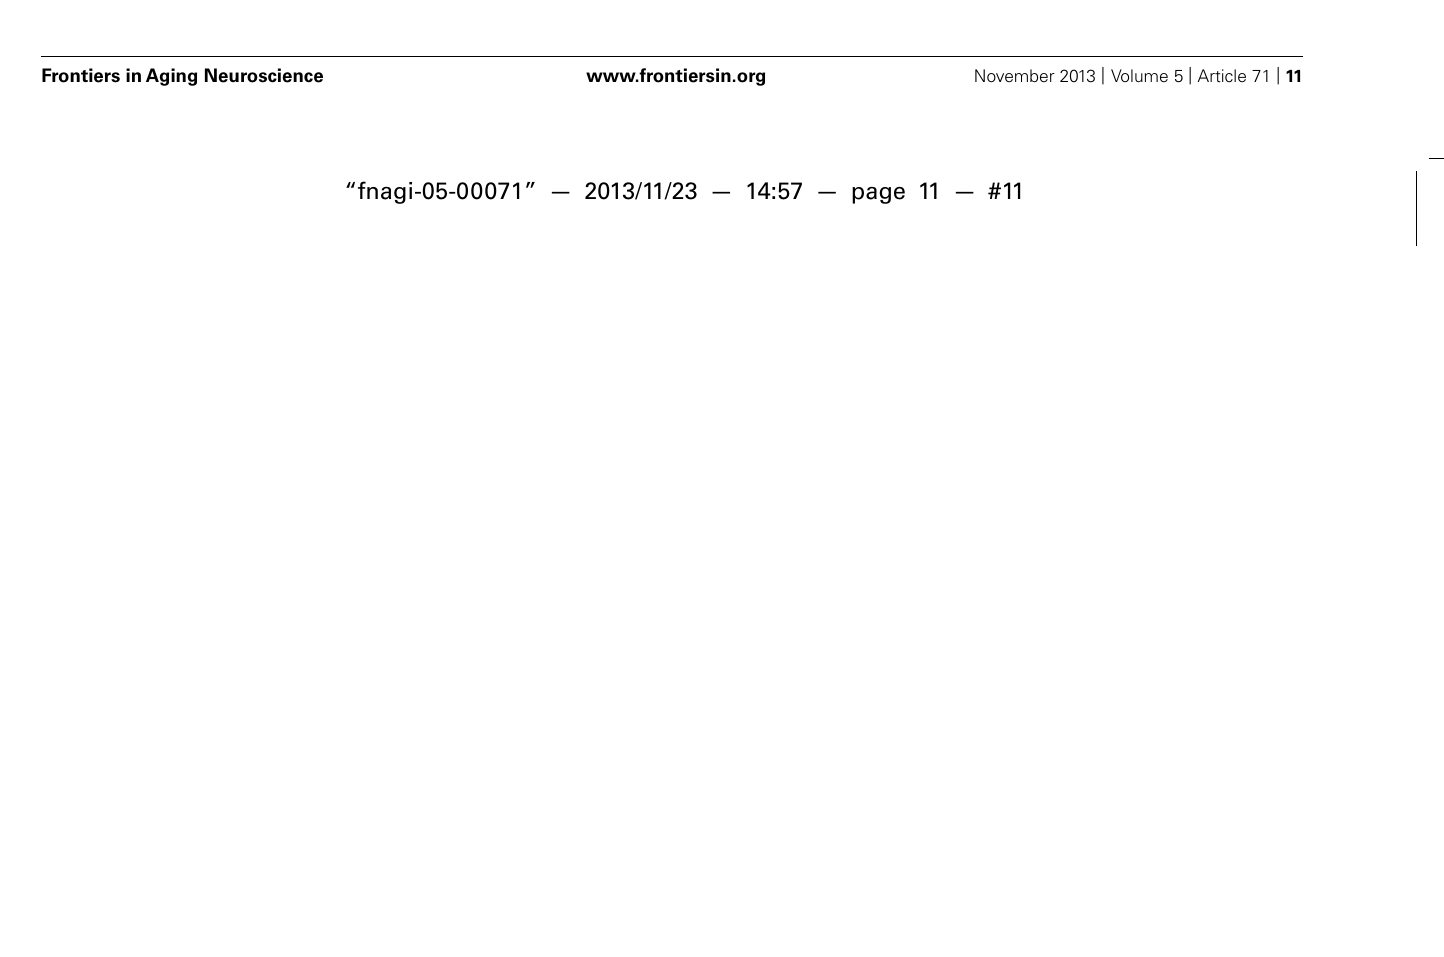
Table 2 summarizes the p-values of the contributions from sex and aging, respectively, in parcellated cortical regions where the two-way analysis of variance reached significance for mean diffusivity (MD) and diffusion kurtosis (MK). NS,